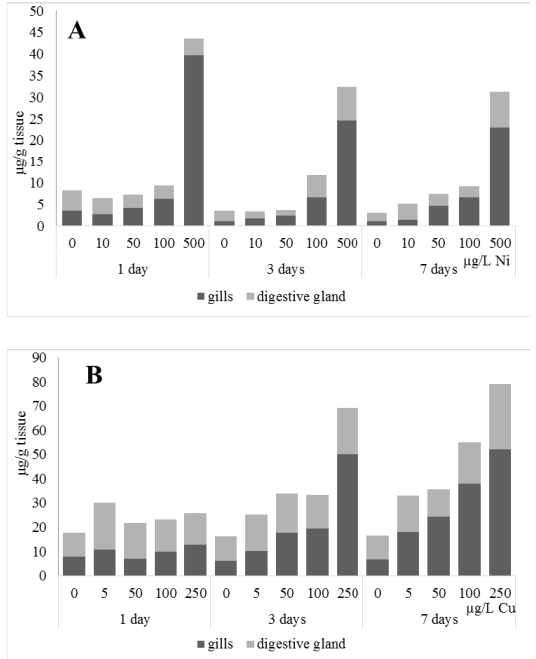
Figure 1. Content of Ni and Cu (µg/g tissue) in the gills and digestive gland of A. cygnea under nickel ( A ) and copper ( B ) experimental effects.